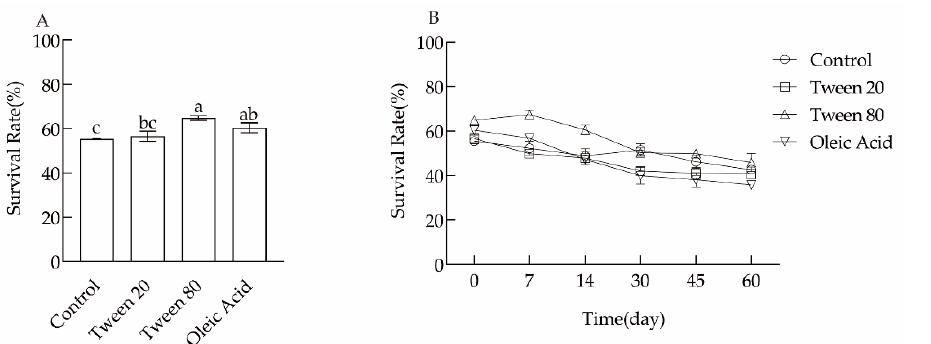
Figure 2. Effects of exogenous fatty acids on the lyophilization survival rate ( A ) and storage of L. plantarum ( B ). Different letters indicate significant differences ( p < 0.05).